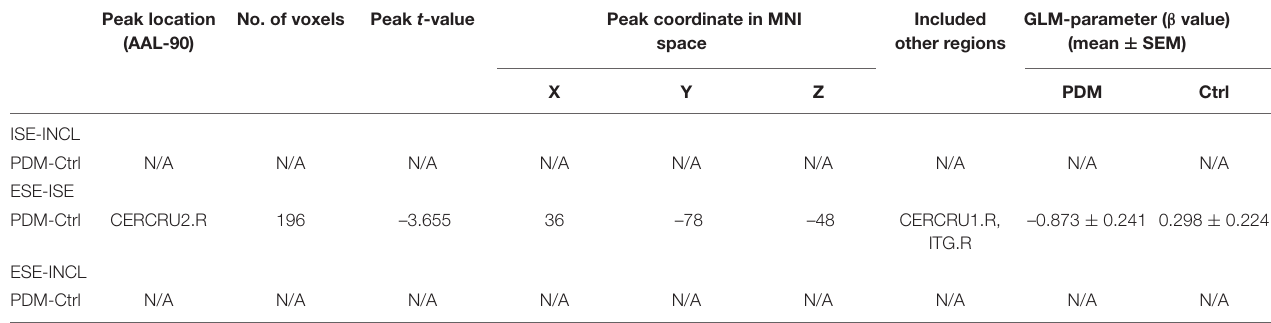
TABLE 2 | Specific brain regions show significant group differences in activation for ISE-INCL, ESE-ISE, ESE-INCL contrasts. Peak location